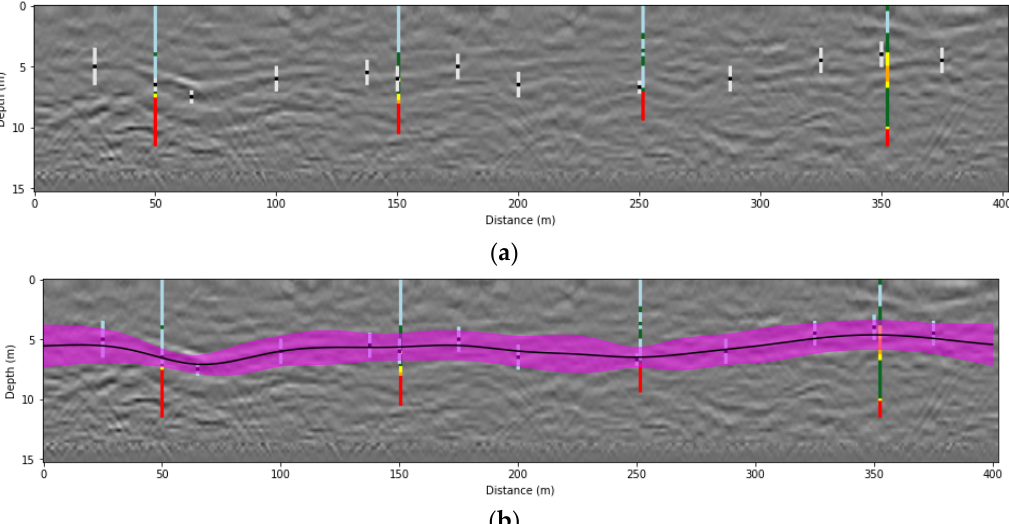
Figure 9. Boundary estimates with the uncertainties of geologist 3 are shown ( a ), with the resulting estimate of the boundary across the region ( b ).